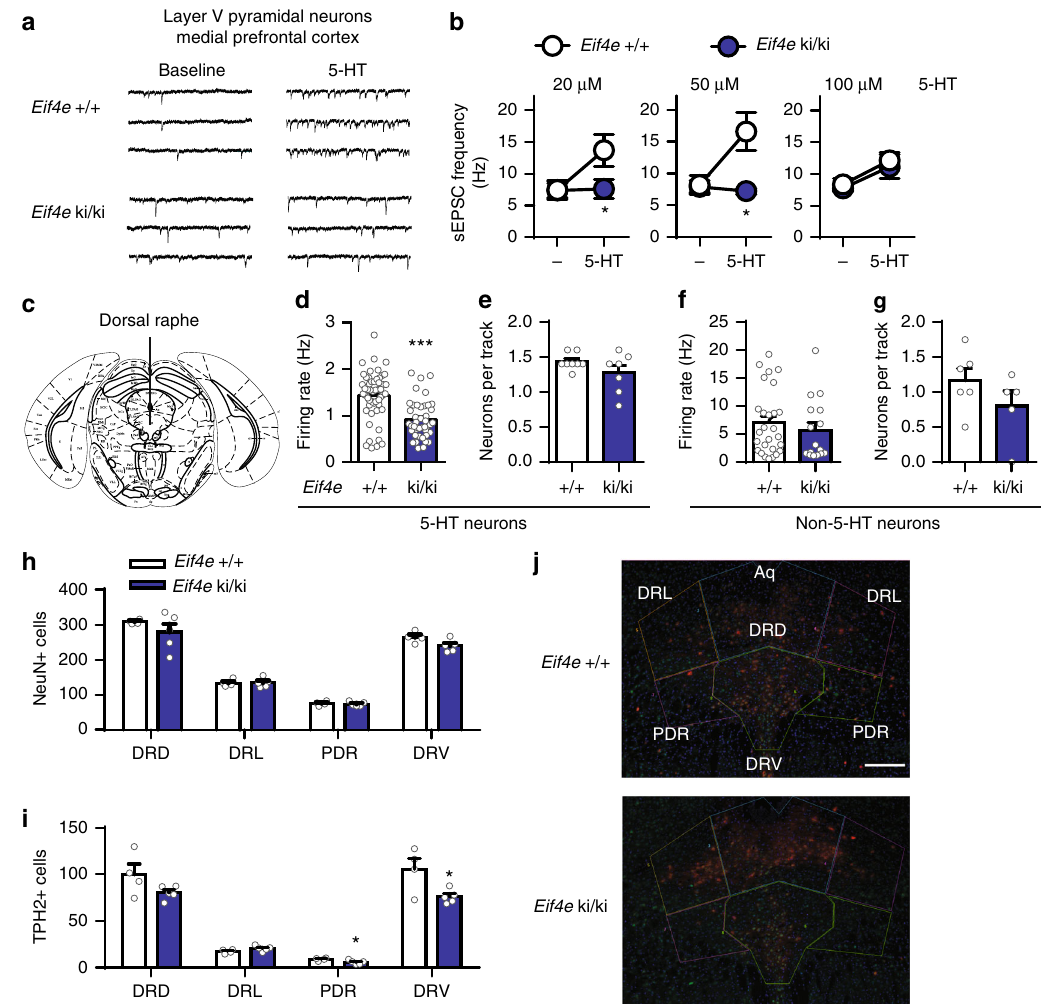
Fig. 2 Serotonergic dysfunction in Eif4e ki/ki mice. a Representative whole cell recordings of spontaneous excitatory post-synaptic currents (sEPSCs) from layer V pyramidal neurons of the medial prefrontal cortex (mPFC) of wild-type and Eif4e ki/ki mice. Traces represent consecutive recordings of synaptic currents before (baseline) and after 5-HT (20 μ M) treatment from single pyramidal cells in each group. b Frequency of sEPSCs from pyramidal neurons of wild-type and Eif4e ki/ki mice before ( − ) and after 5-HT at 20 μ M ( n = 7 cells from 5 Eif4e + / + ; n = 8 cells from 7 Eif4e ki/ki), 50 μ M ( n = 4 cells from 3 Eif4e + / + ; n = 5 cells from 3 Eif4e ki/ki) or 100 μ M ( n = 5 cells from 3 Eif4e + / + ; n = 6 cells from 3 Eif4e ki/ki). c In vivo single-unit extracellular recordings of dorsal raphe neurons were performed in anesthetized Eif4e + / + and ki/ki mice. d Firing rate of dorsal raphe 5-HT neurons, measured in Eif4e + / + and ki/ki mice ( n = 56 single unit recordings from 8 Eif4e + / + mice; n = 43 single unit recordings from 7 Eif4e ki/ki mice). e 5-HT neurons recorded per descent (track) in the dorsal raphe of wild-type and Eif4e ki/ki mice ( n = 8 Eif4e + / + mice; n = 7 Eif4e ki/ki mice). f Firing rate of non-5-HT neurons in the DR ( n = 27 single unit recordings from 6 Eif4e + / + mice; n = 16 single unit recordings from 5 Eif4e ki/ki mice). g Number of non-5-HT neurons per descent in the DR ( n = 6 Eif4e + / + mice; n = 5 Eif4e ki/ki mice). h Number of NeuN + cells in the DR nuclei, which was subdivided into DR dorsal part (DRD), DR lateral part (DRL), posterodorsal raphe nucleus (PRN), and DR ventral part (DRV). Data are means of 4 slides per animal ( n = 4 Eif4e + / + mice; n = 5 Eif4e ki/ki mice). i Number of tryptophan hydroxylase 2 (TPH2) positive cells in the DRN. j Representative images of the DR IHC; blue: nuclear DAPI staining; red: TPH2; green: NeuN. Scale bar is 100 μ M. * p < 0.05, *** p < 0.001 vs. wild-type littermates (see Supplementary Table 2 for detailed results of statistical